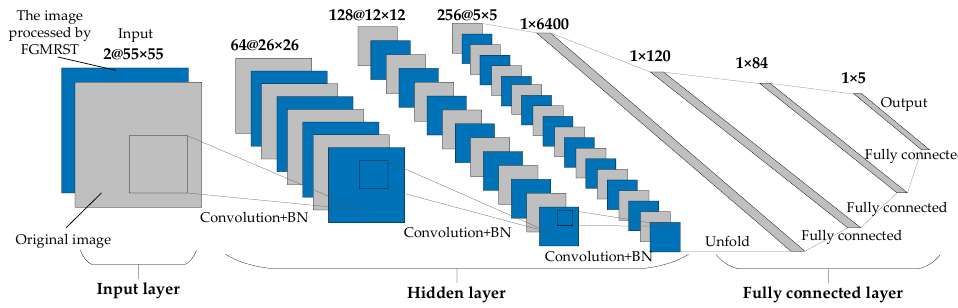
Figure 14. Structural model of net_conv3.